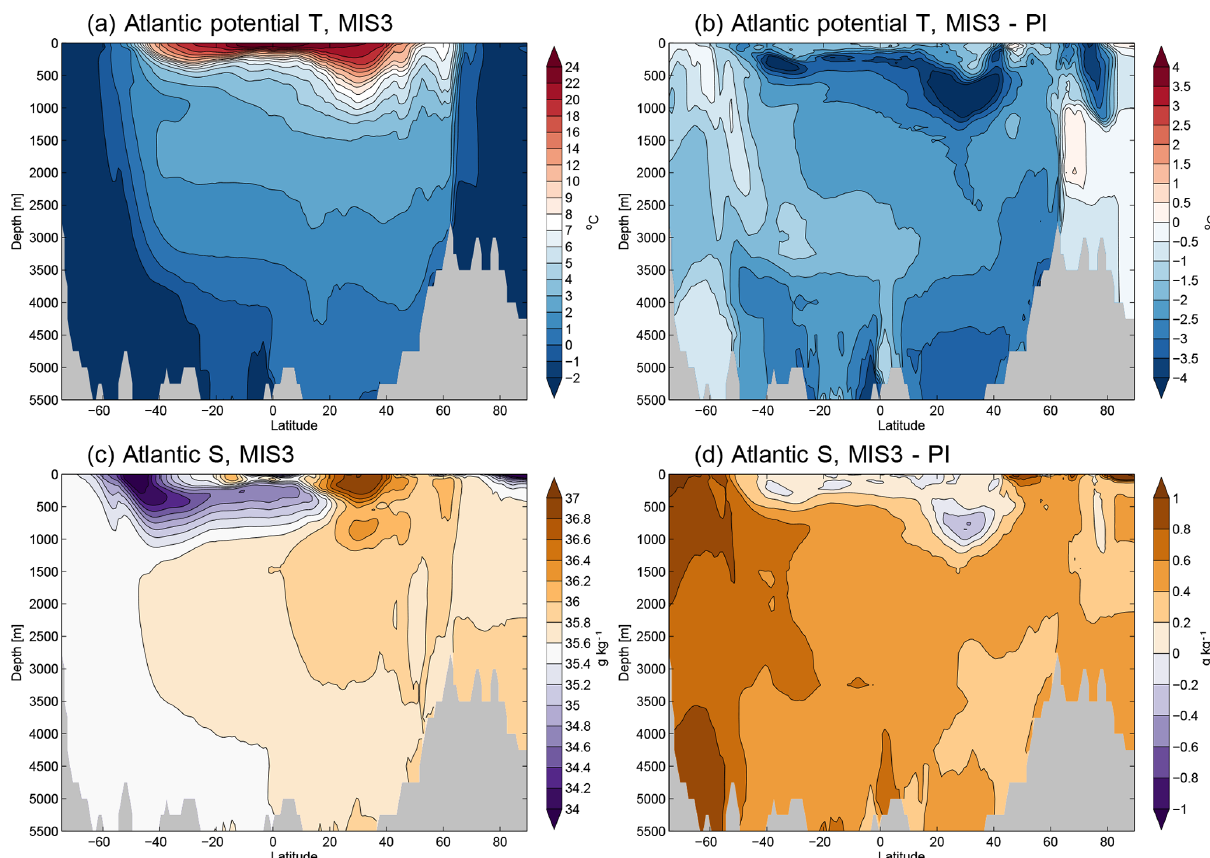
Figure 10. Atlantic zonal mean (a) potential temperature and (c) salinity for the MIS3 experiment and (b, d) anomalies relative to PI.